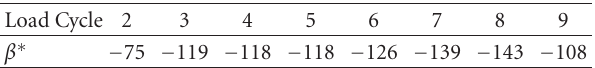
Table 3: The average values of dimensionless nonlinear parameter β ∗ for di ff erent load